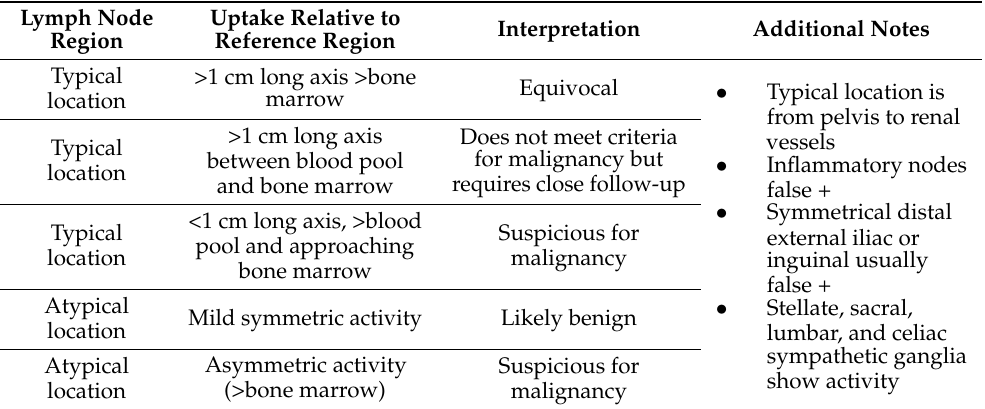
Table 6. Lymph nodes. Interpretive criteria for 18 F fluciclovine (Axumin ® ) for lymph nodes in patients with prostate cancer